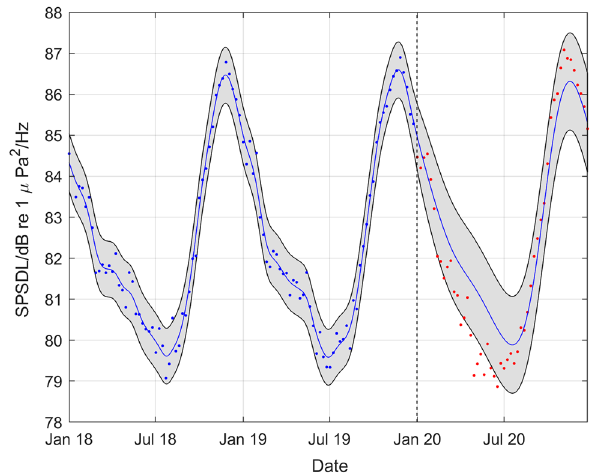
Figure 4. Part of Fig. 2 restricted to the period January 2018 to December 2019, showing also the observed weekly SPSDL data in 2020 and the predictions of SPSDL in 2020 provided by the GP with their corresponding uncertainty band.